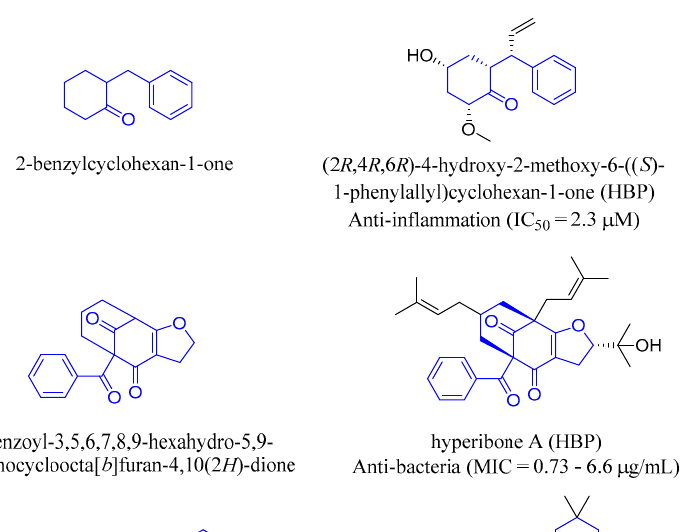
Figure 11. Structural diversity of HBP, SBP and reference compound datasets. ( A ) Fingerprint-based diversity; ( B ) scaffold diversity—CSR curve; ( C ) scaffold overlap; ( D ) four overlapped scaffolds present in all four datasets.